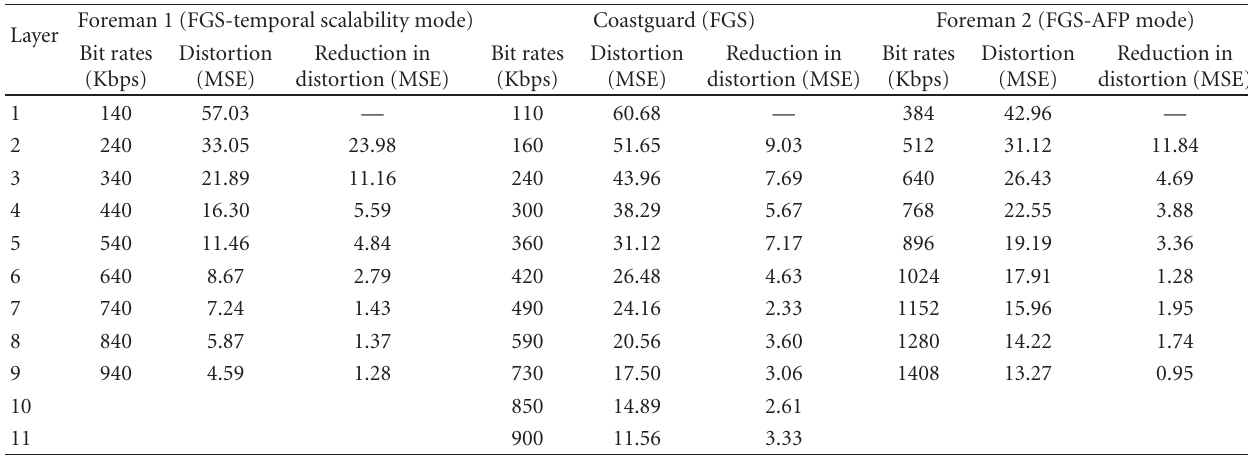
Table 2: Standard video profiles—set